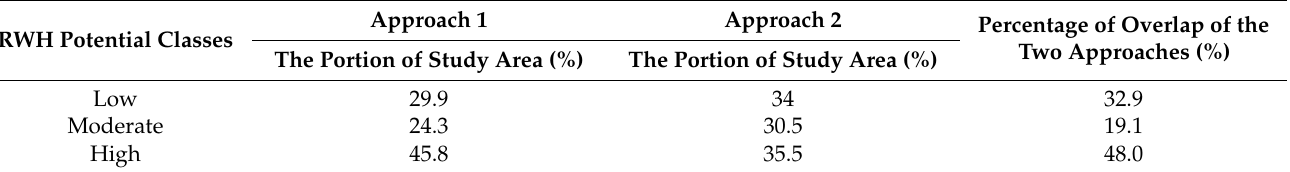
Table 4. Three classes of potential RWH using two